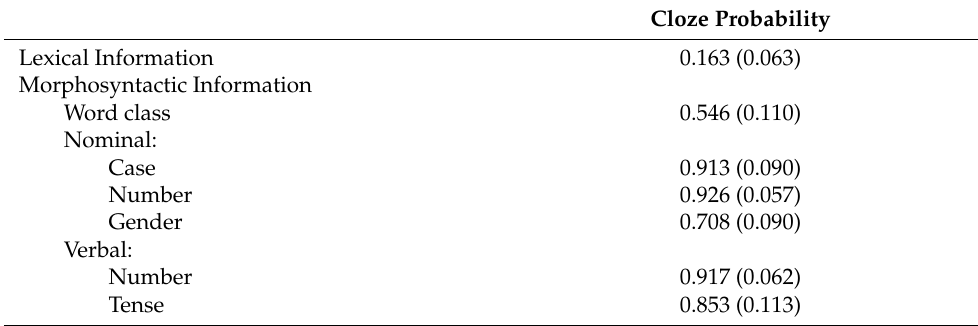
Table 2. Mean cloze lexical and morphosyntactic probabilities (SDs).